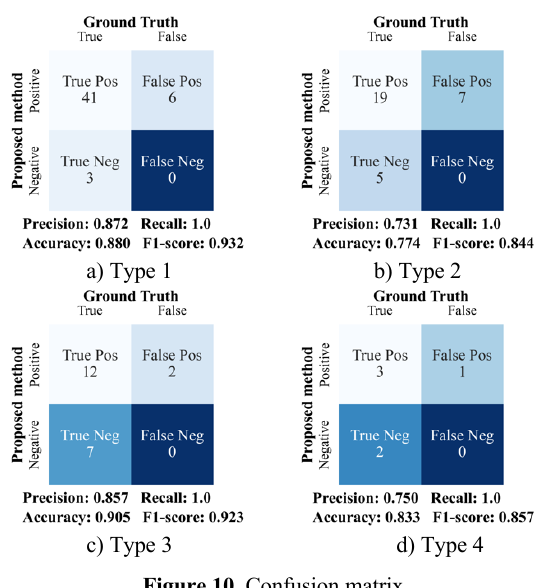
Figure 10 . Confusion matrix